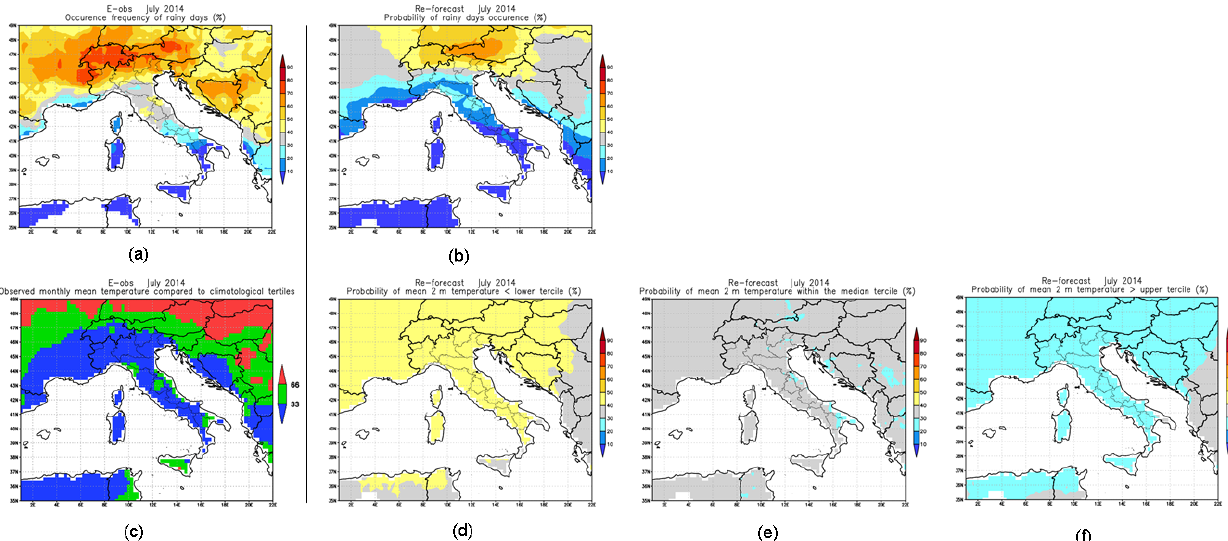
Figure 5. July 2014: observations E-OBS versus the operational chain re-forecast: the E-OBS occurrence frequency of rainy days (a) , the re-forecast probability of the rainy days occurrence (b) , the E-OBS tertile climatological distribution (c) , the re-forecast probability to stay below the lower tertile (d) , the re-forecast probability to stay within the median tertile (e) and the re-forecast probability to stay above the upper tertile (f)